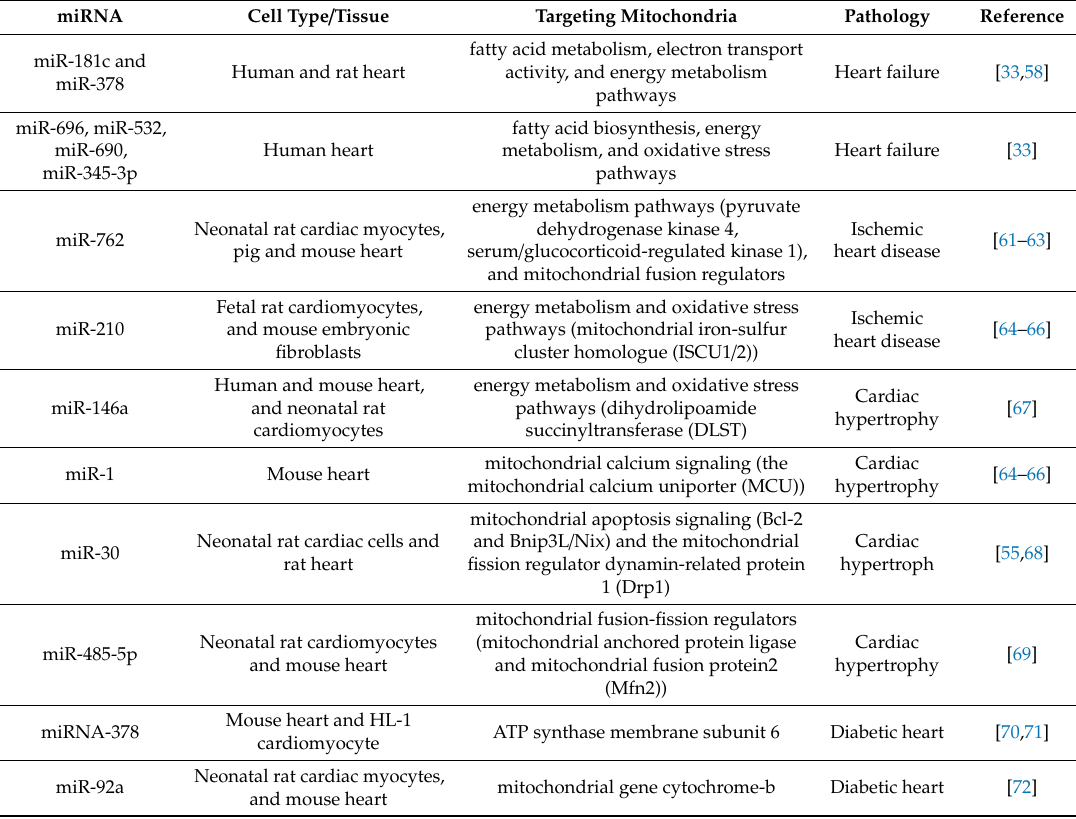
Table 1. The role of mitomiRs in cardiac